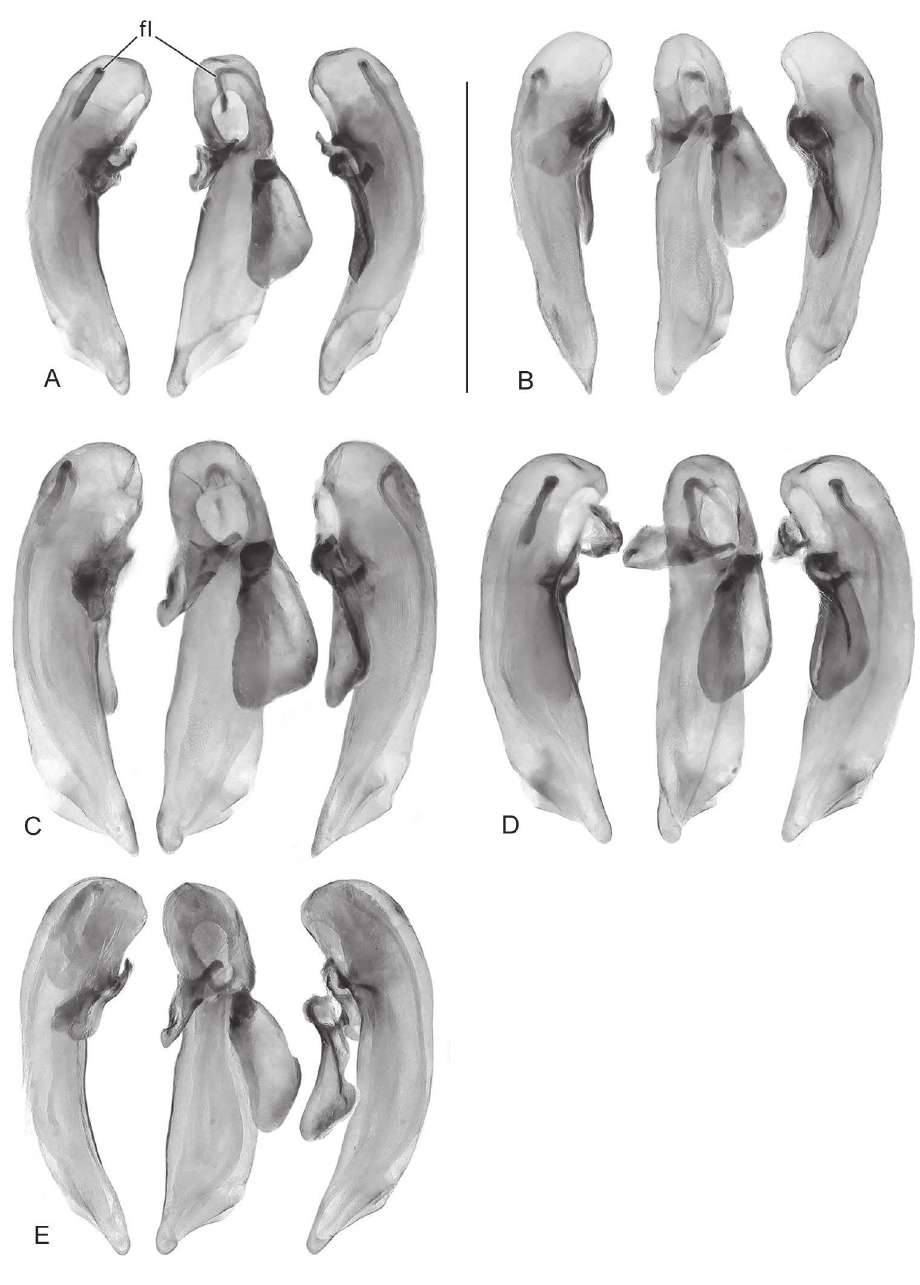
Figure 10. Digital Photo-illustration, male aedeagus in repose, dorsal, ventral, left lateral aspects: A Hy- boptera apollonia Erwin, ADP100266 B Hyboptera dilutior Oberthür, ADP134143 C Hyboptera lucida Henry & Erwin, sp. n., ADP135785 D Hyboptera tuberculata (Dejean), ADP135797 E Hyboptera ver- rucosa (Reiche), ADP082523. Legend, fl, flagellum. Scale line = 0.25